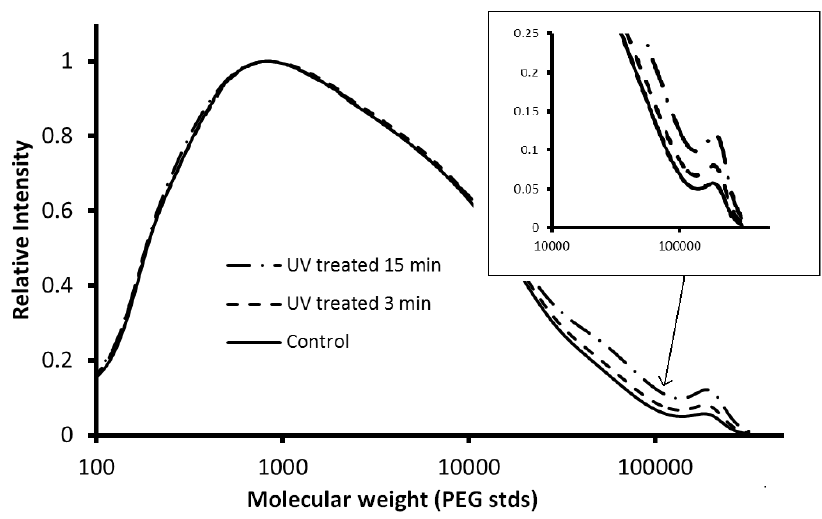
Figure 6. Gel permeation chromatography (GPC) chromatograms of Ace-SKL fiber samples with different UV treatment